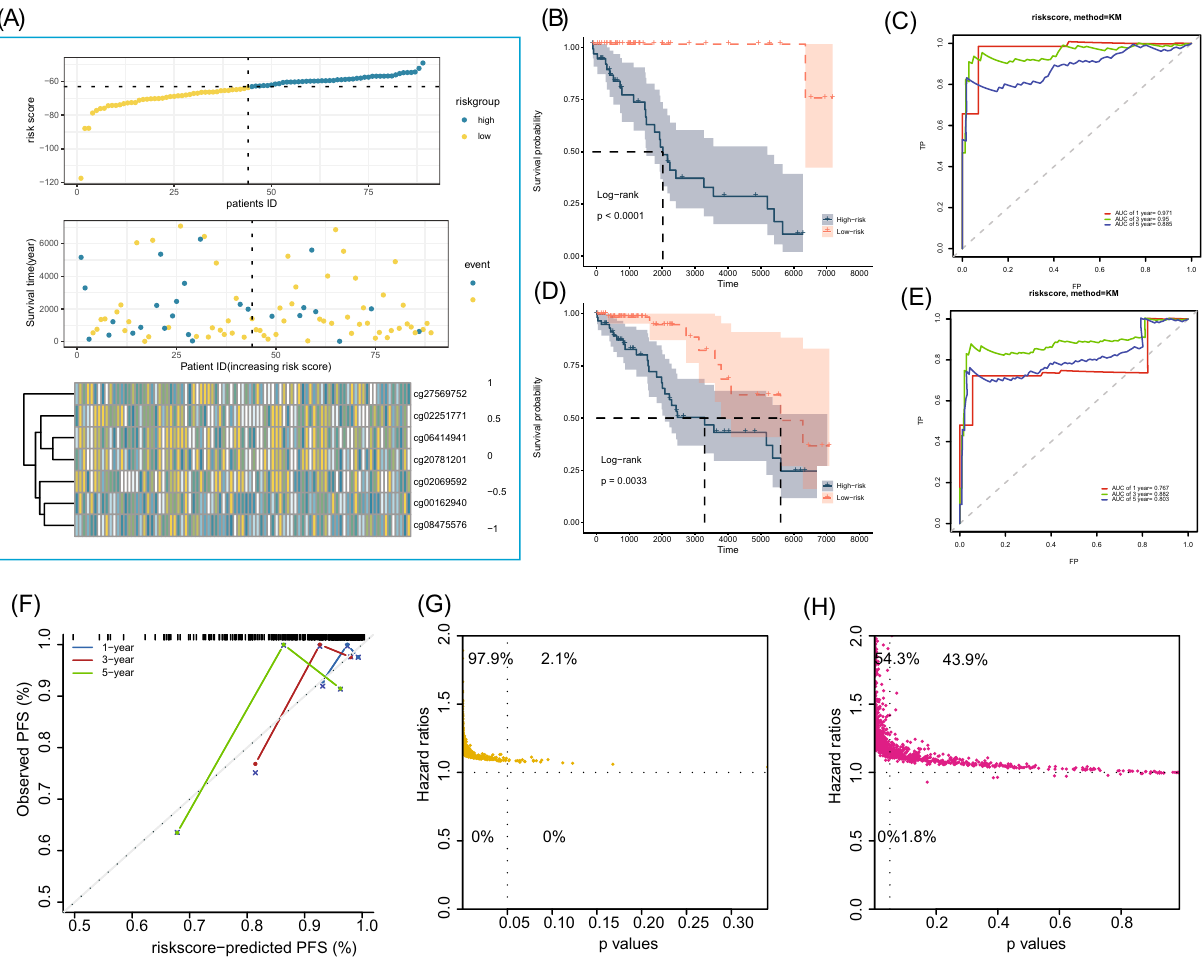
Figure 3. Construction and validation of CpG sites-derived risk score model. ( A ) Distribution of the risk score, survival status, and methylation status of included CpG sites in the training cohort. ( B ) K–M curves of high- and low-risk groups in the training cohort; ( C ) receiver operating characteristic curve of the risk score in predicting the 1-, 3-, and 5-PFS in the training cohort. ( D ) K–M curves of high- and low-risk groups in the entire cohort; ( E ) receiver operating characteristic curve of the risk score in predicting the 1-, 3-, and 5-PFS in the entire cohort. ( F ) The calibration curve of the risk score on the predicted PFS was obtained by self-sampling the entire cohort for 1000 times (39 samples each). ( G , H ) The HR and p-value distributions of the risk score in predicting PFS by randomizing the entire cohort 1000 times (at a ratio of